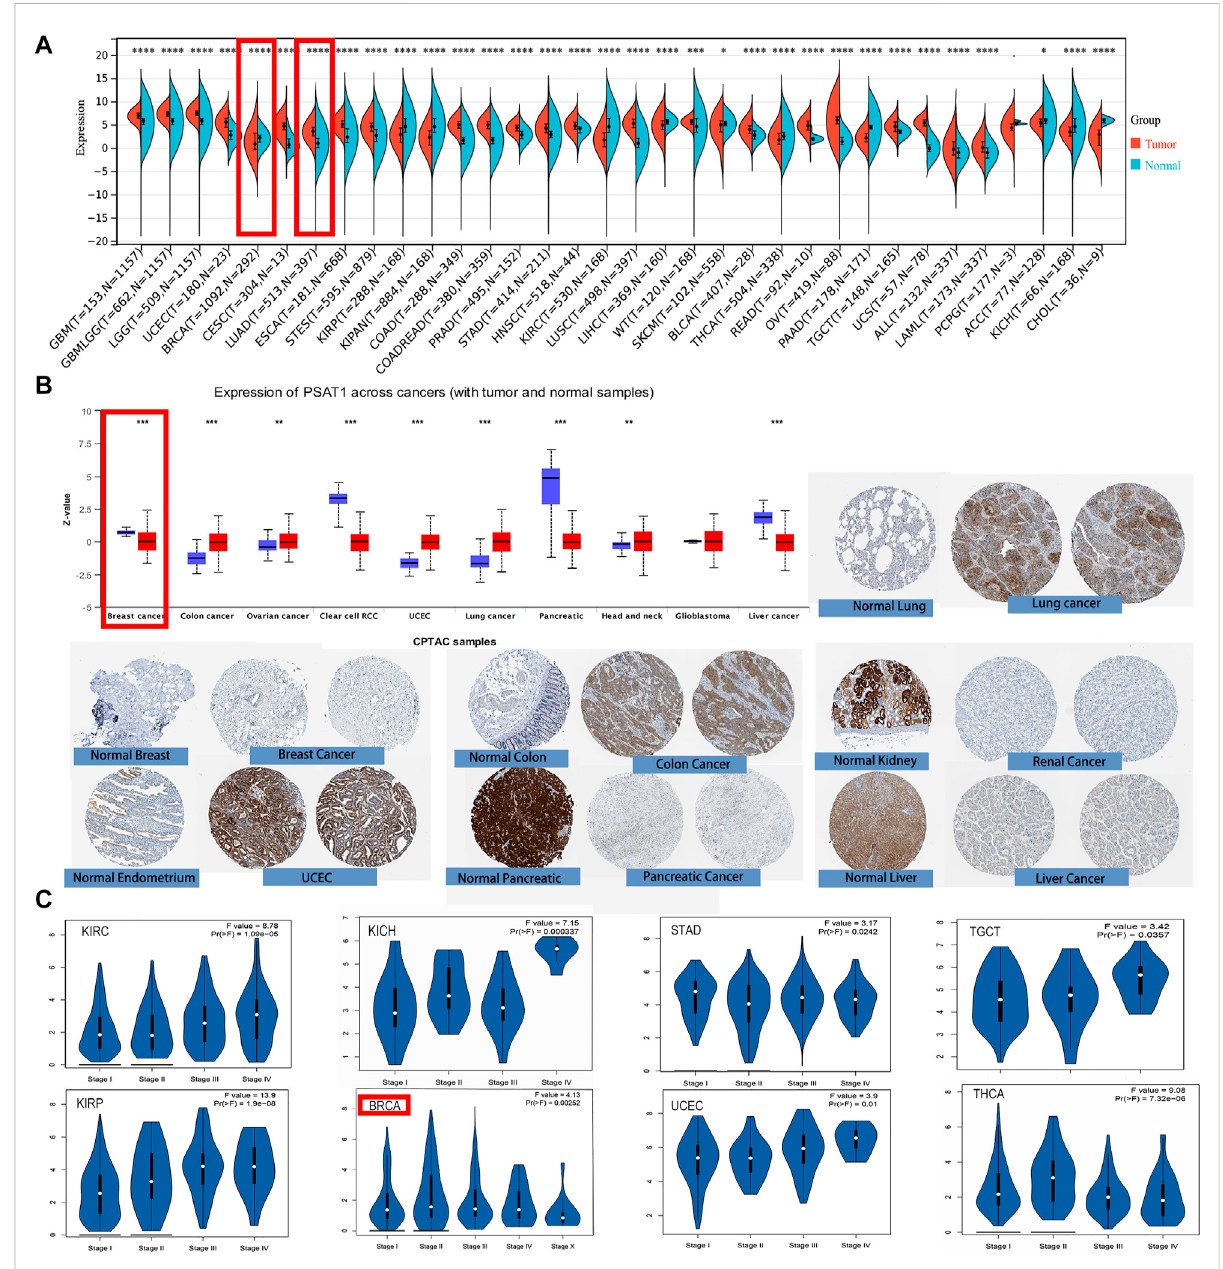
FIGURE 2 PSAT1 gene expression in cancers and different pathological stages of the same tumor. (A) Increased or decreased expression of PSAT1 in different cancers or speci fi c cancer subtypes through TIMER2. * p < 0.05; *** p < 0.001; *** p < 0.0001. (B) PSAT1 total protein expression between normal and primary tissues of breast cancer, colon cancer, ovarian cancer, clear cell RCC, UCEC, lung cancer, pancreatic cancer, head and neck cancer, GBM and liver cancer through the CPTAC dataset. ** p < 0.01; *** p < 0.001. (C) Analyzing the expression level differences of PSAT1 in different pathological stages of BRCA, KICH, KIRC, KIRP, STAD, TGCT, THCA, UCEC through TCGA